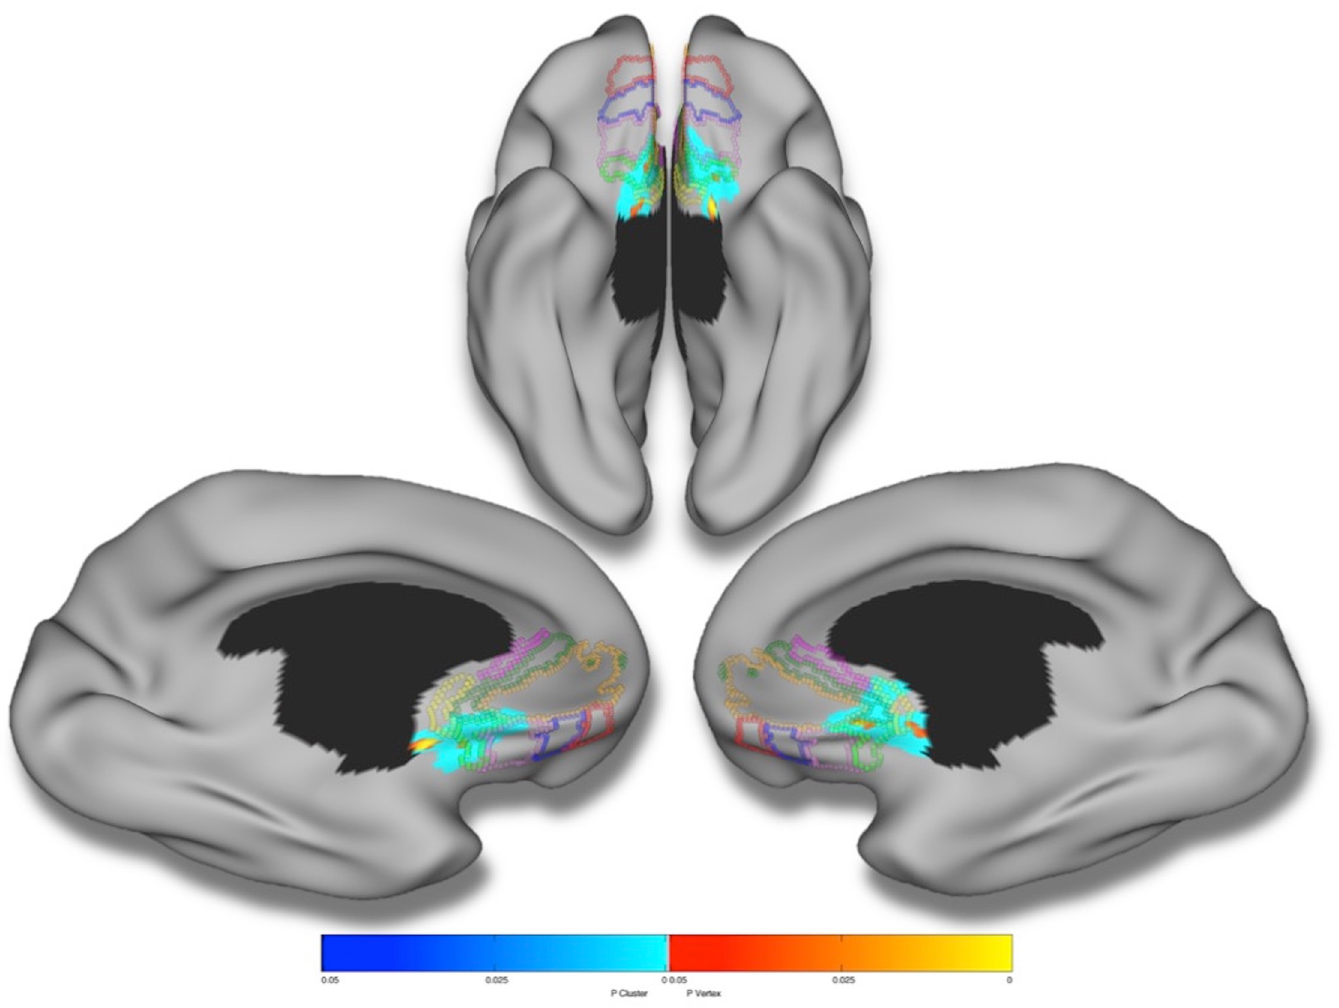
Fig 1. Amygdalar reactivity and cortical thickness. Brain areas in which local cerebral cortical thickness is associated with the continuous measure of amygdalar activation (i.e., angry minus neutral face contrast) in a second-order (quadratic) model over the whole sample (n = 1753). Figure is shown at p � 0.05, RFT corrected. Blue areas are significant at the cluster level and red color corresponds to areas significant at the vertex level. Controlled for age, total brain volume, sex, site, handedness, Performance IQ, Verbal IQ, SES and pubertal development. Colored borders correspond to the maximum symmetric probability map derived from the cytoarchtectonic studies of Mackey & Petrides (2014).